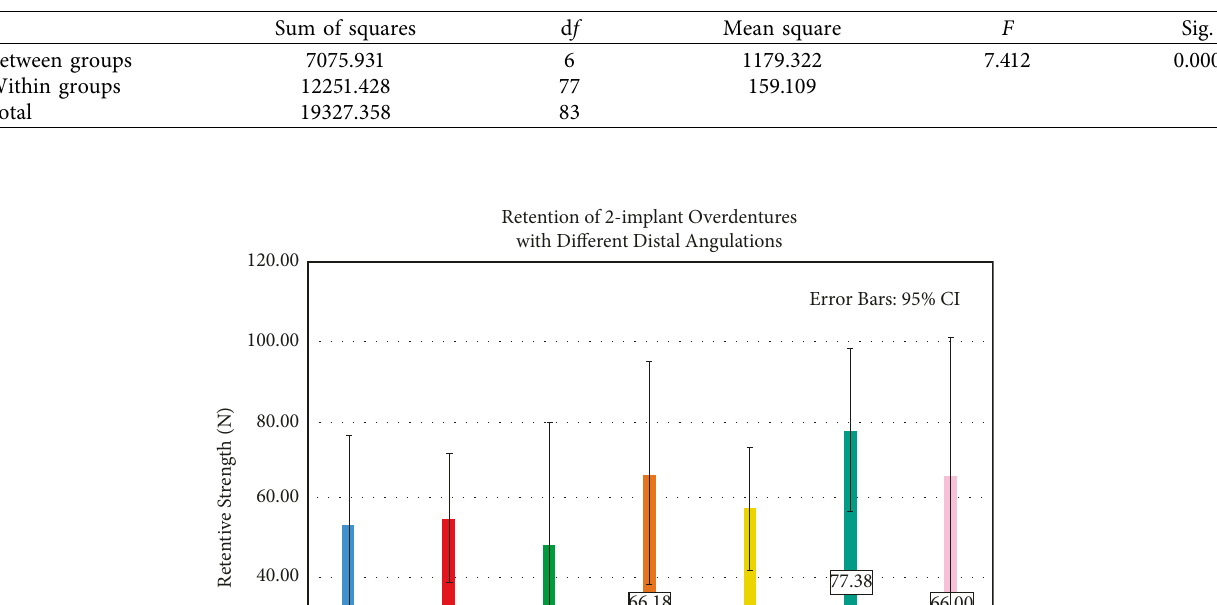
Table 5: ANOVA with different implant angulations.